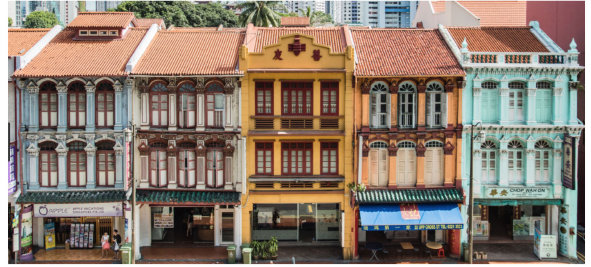
Figure 14. Traditional shop houses in Singapore’s Chinatown